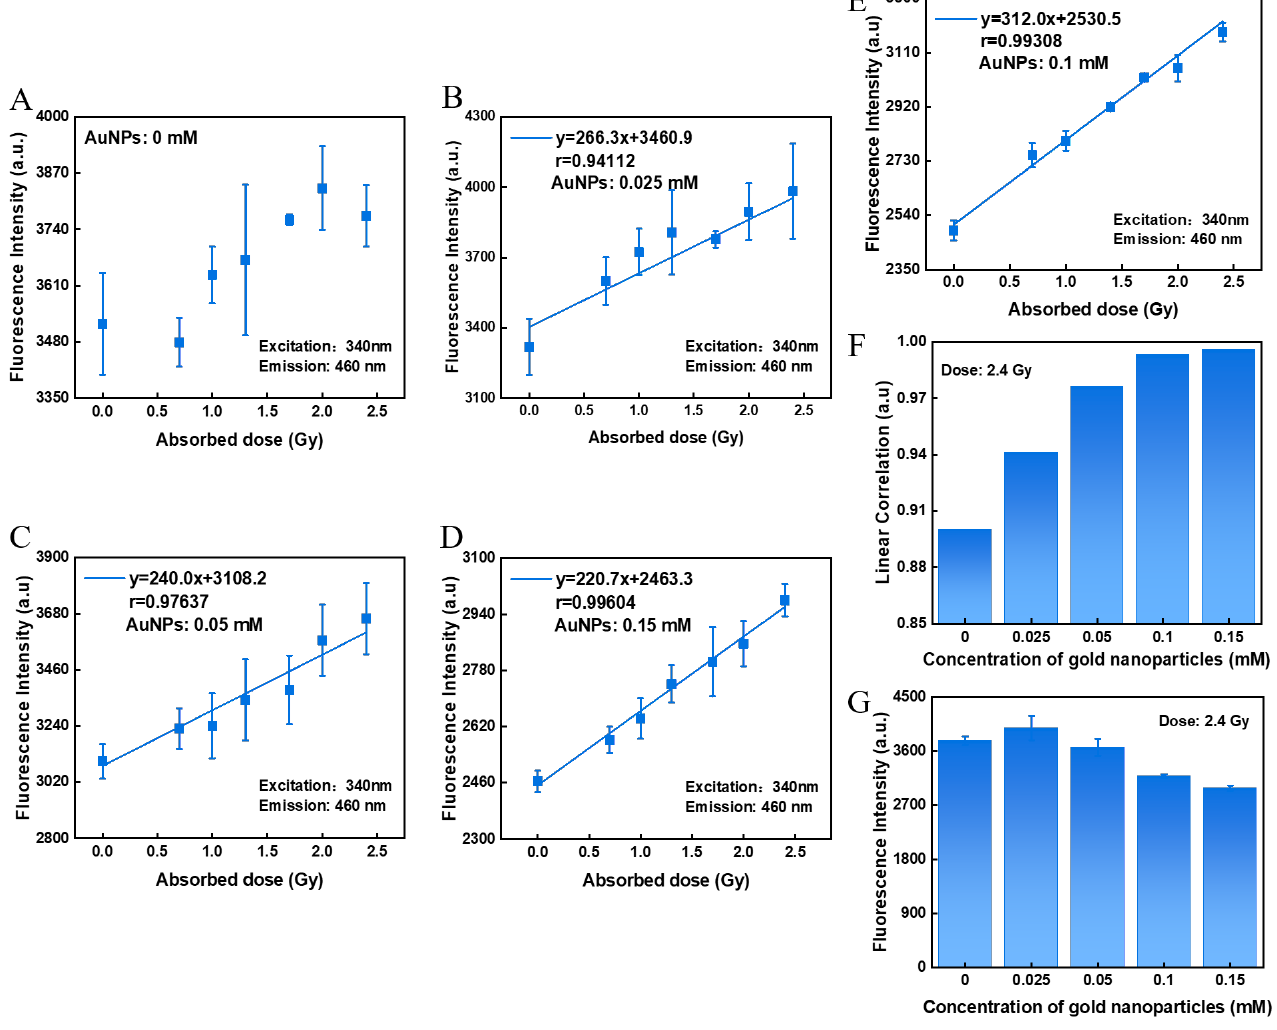
Figure 2. Effect of GNP concentration on the fluorescence intensity and dose-response of the hydrogel sensor. ( A – E ) The relationship between dose and fluorescence intensity of the hydrogel sensors with 0 mM, 0.025 mM, 0.05 mM, 0.15 mM, and 0.1 mM of GNPs. ( F ) The effect of GNP concentration on their linear fitting coefficients. ( G ) Effect of GNP concentration on fluorescence intensity at an irradiation dose of 2.4 Gy. In ( A – G ) the concentration of COU in the sensor is 0.5 mM and the mass fraction of agarose is 3 wt %.